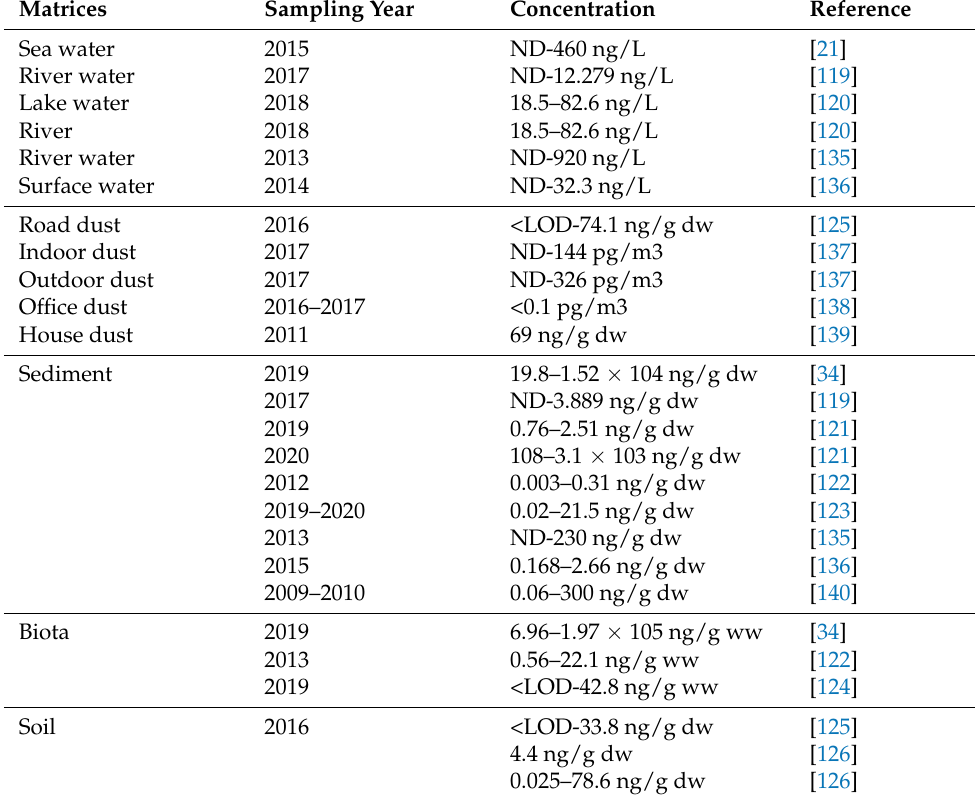
Table 2. Concentrations of TBBPA in water, dust, air, sediment and